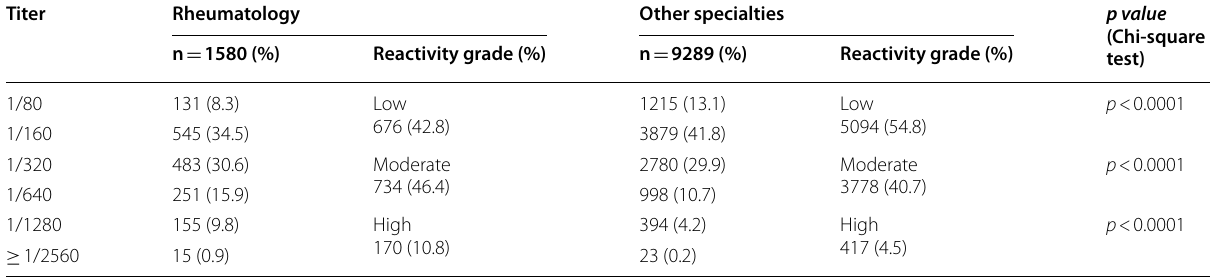
Table 1 HEp-2-IIF titers in 10,869 positive samples, according to referral specialty (rheumatology versus other